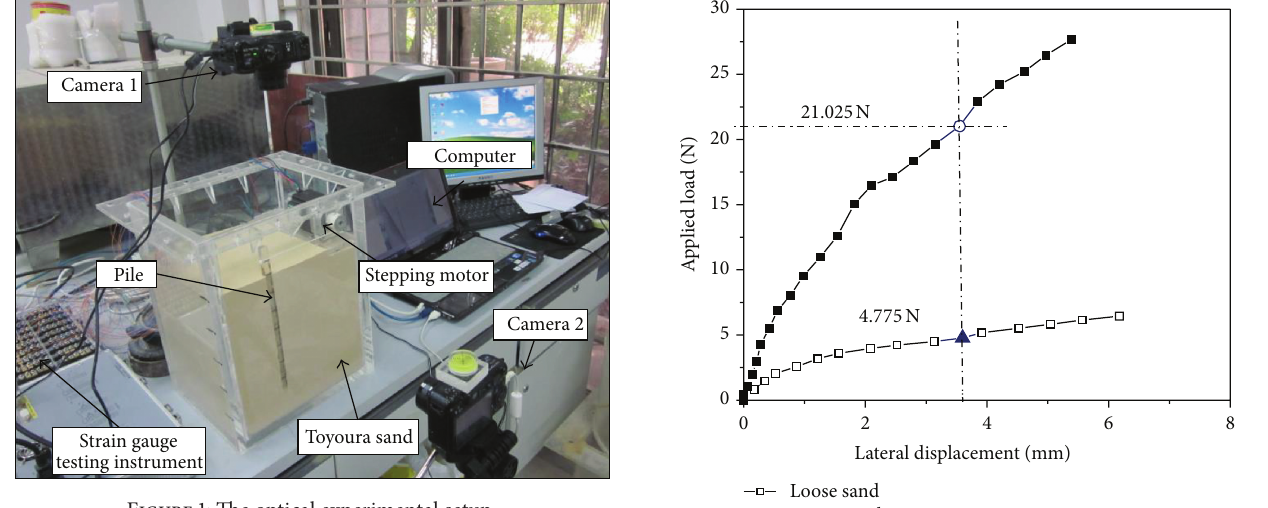
Figure 1: The optical experimental setup.